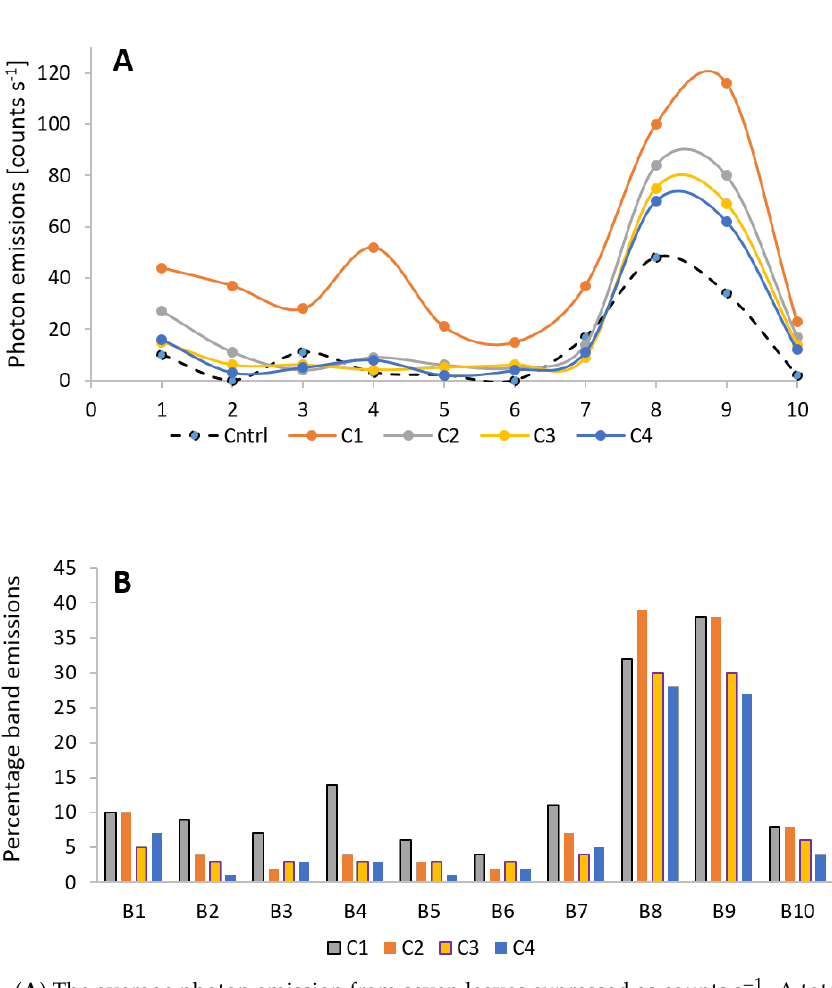
Figure 6. ( A ) The average photon emission from seven leaves expressed as counts s − 1 . A total of four cycles measured after mechanical injury presented as C1–C4 against the control (non-injured). The dots in 6A represent the BE ( B ). Band emissions (BE) [Equation (2)] obtained relative to interpolated total emission (ITE) for the first four cycles C1 to C4.